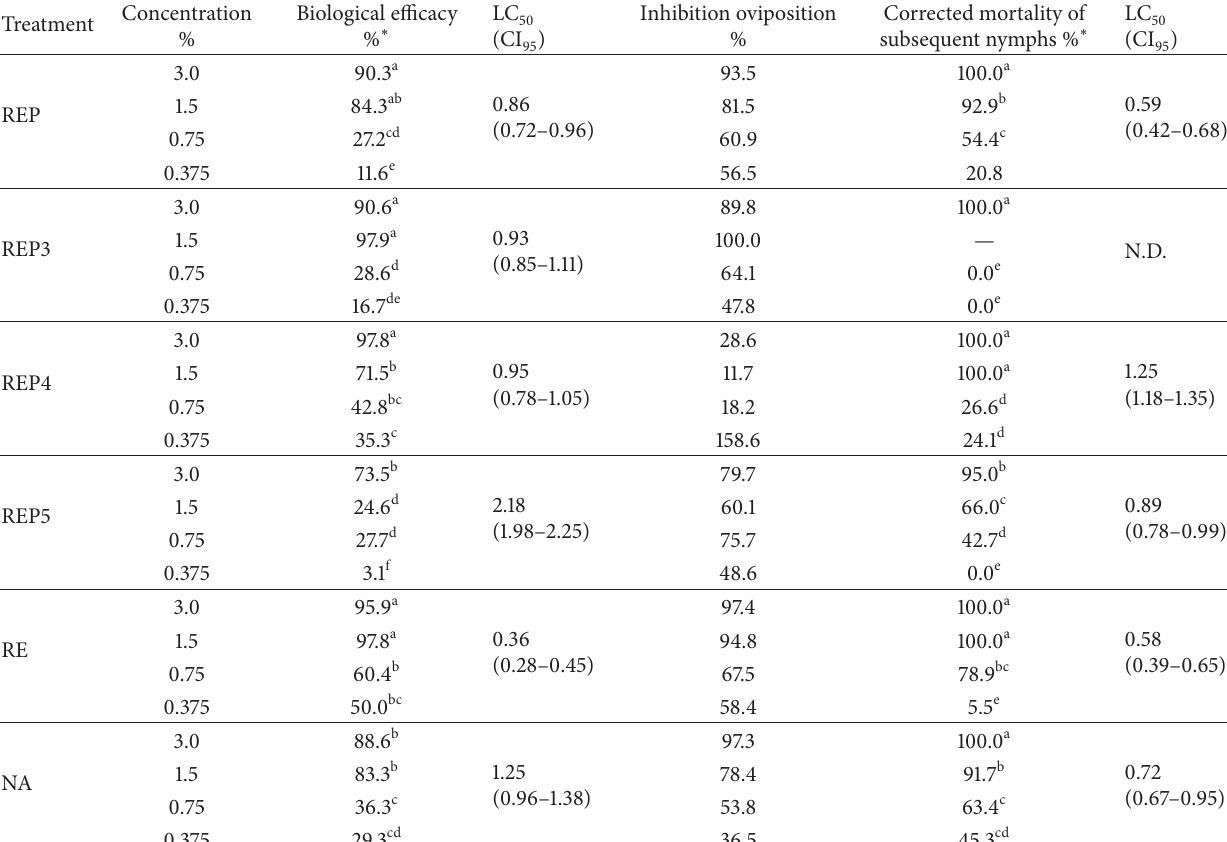
Table 1: Activity of plant preparations to green peach aphid female and to its offspring.